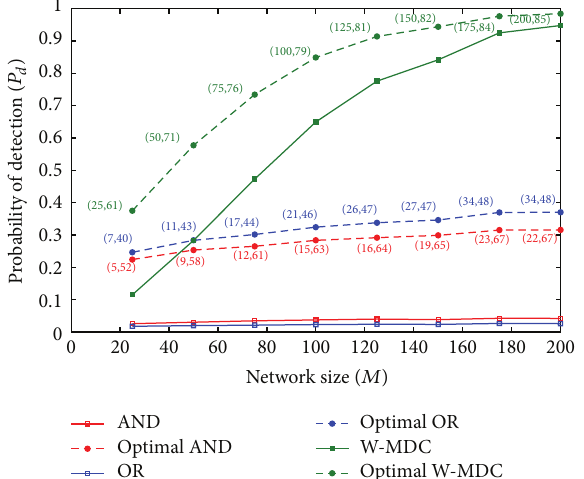
Figure 7: Network 𝑃 𝑑 versus time frame duration ( 𝑇 in 𝜇 s) with target throughput of 0.9 for AND, OR, and weighted MDC fusion scheme; network with 100SUs with ( 𝑘 opt ,𝜏 opt ) is shown in the data tips.